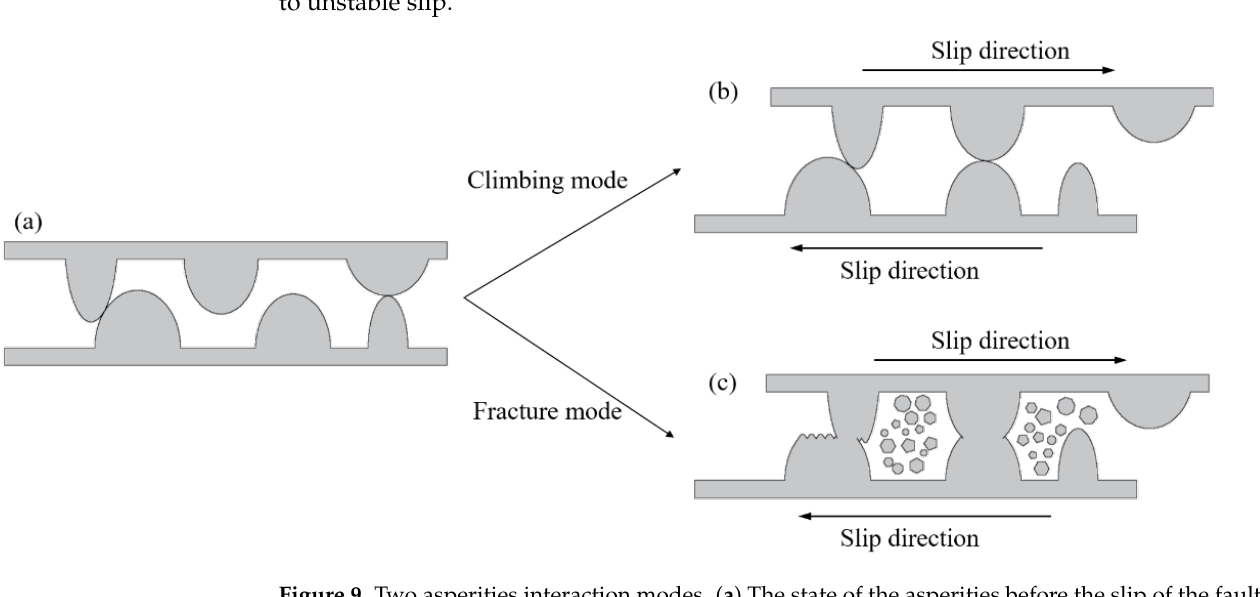
Figure 9. Two asperities interaction modes. ( a ) The state of the asperities before the slip of the fault block. ( b ) Climbing mode: When the normal stress is small, the asperities will not break. The friction behavior is mainly dominated by the overriding/climbing between the asperities. ( c ) Fracture mode: Fracture of the asperities occurs due to large shear stress when the normal stress is large. Fracture mode associated with the production of fault gouge [15].